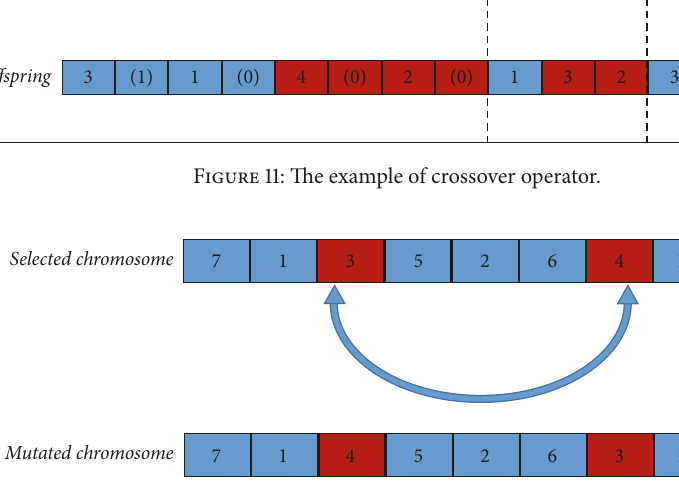
Figure 12: The example of mutation